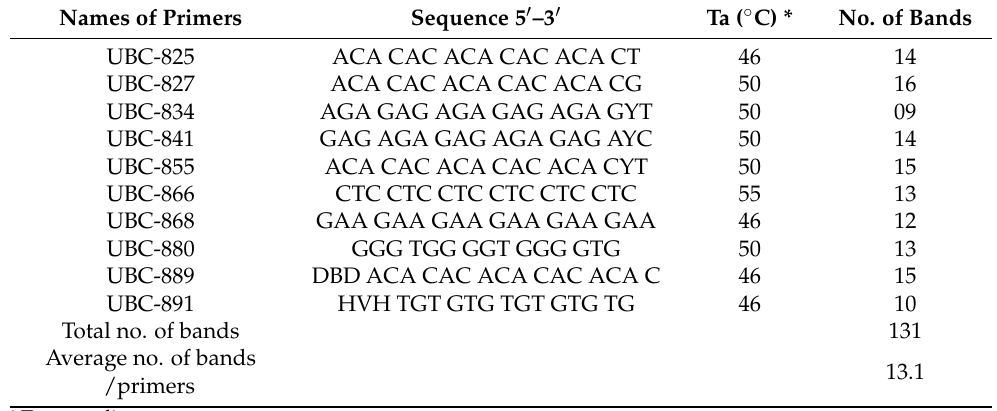
Table 8. Inter simple sequence repeat (ISSR) primers used to evaluate the genetic fidelity of ex-vitro- established micropropagated R. chalepensis plants.